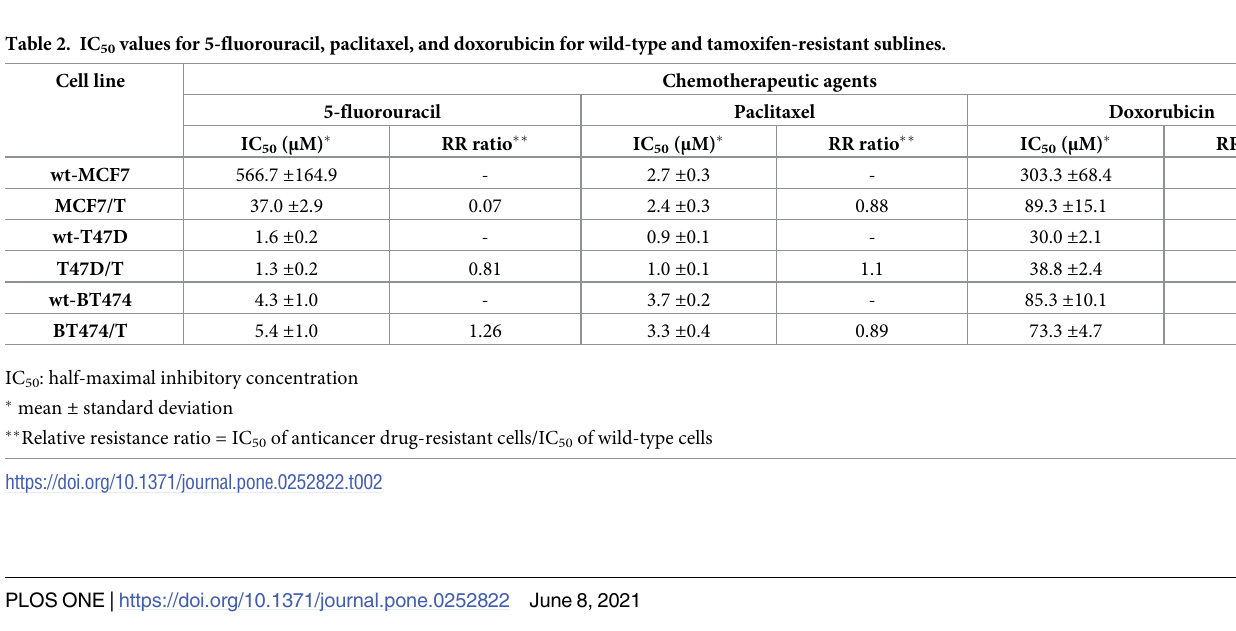
Fig 2. Sensitivity to chemotherapeutic agents in ER-positive breast cancer cell lines and their tamoxifen-resistant sublines. Sensitivity to 5-fluorouracil (a), paclitaxel (b), and doxorubicin (c) in wild-type (wt) and TAM-resistant MCF7 (A), T47D (B), and BT474 (C) cells were determined using the WST assay. Black lines with closed squares ( ■ ) indicate wild-type cells (wt-MCF7, wt-T47D, and wt-BT474), dotted lines with closed circles ( ● ) indicate TAM-resistant sublines (MCF7/T, T47D/T, and BT474/T). Error bars represent standard deviations of the values obtained from triplicate experiments. Each experiment was independently performed and repeated at least three times, and one representative result is provided in the figures.